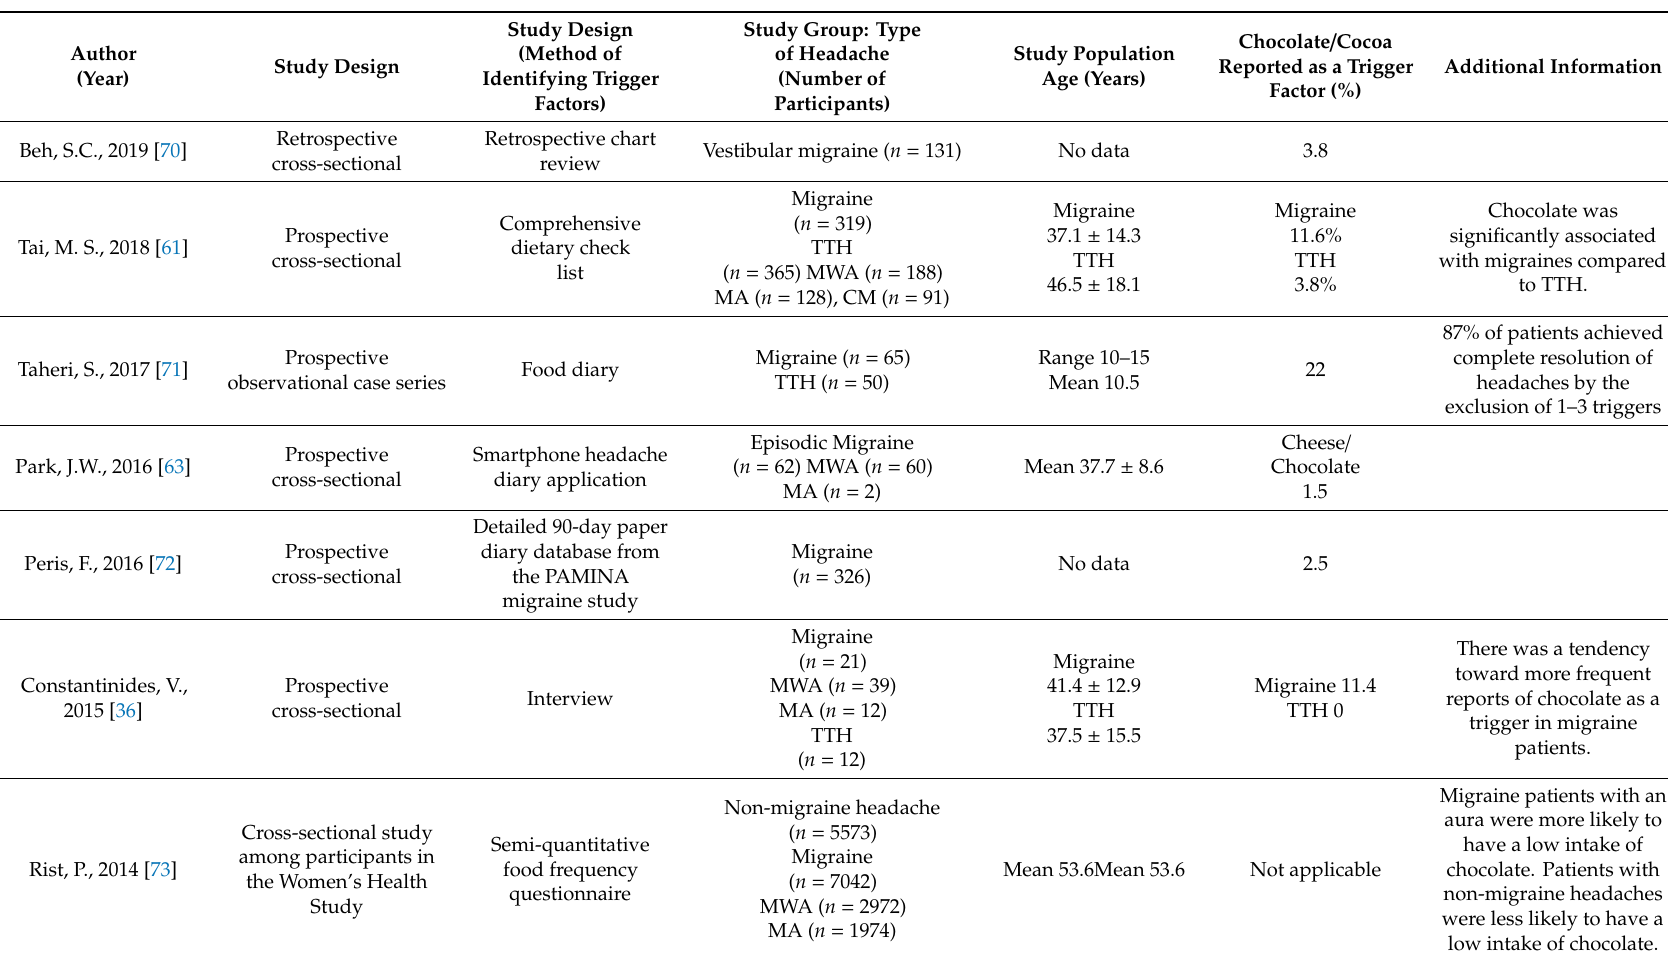
Table 1. Overview of studies investigating the prevalence of chocolate as a trigger factor in migraineurs. Abbreviations: TTH–tension-type headache,